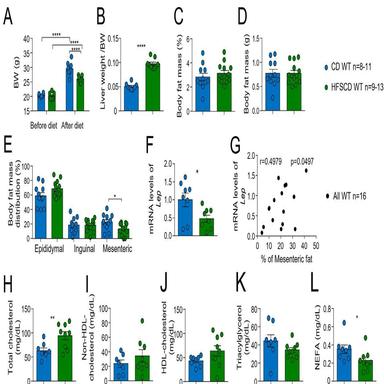
HFSCD feeding of WT mice increases liver weight and circulating cholesterol levels but reduces NEFA blood levels. Body weight (A) and liver weight (B) expressed as percentage of total body weight in both mouse groups before and after 16 weeks of diet. Body fat mass expressed as percentage (C) and as absolute (D) number of total body weight and body fat mass distribution (E) expressed as percentage of total fat in both mouse groups. (F) Lep mRNA levels in mesenteric fat from both mouse groups. (G) Correlatio